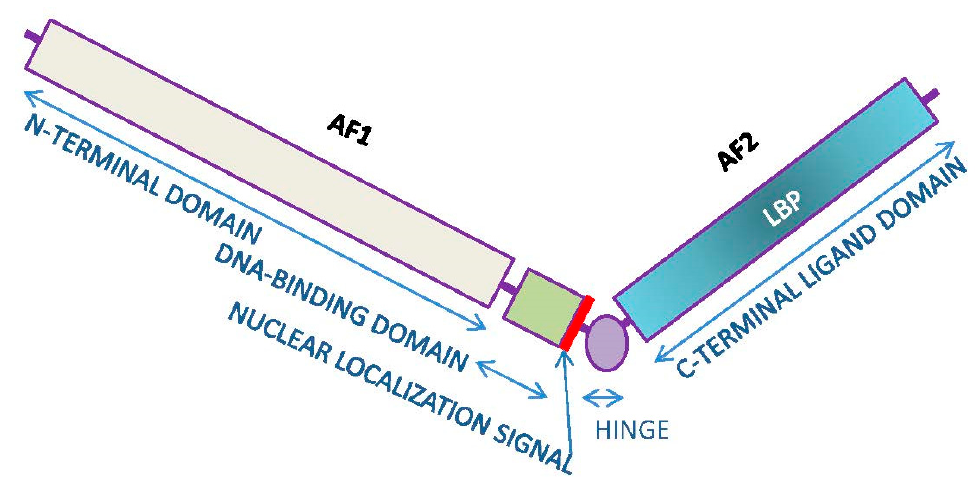
Figure 3. Functional structure of the androgen receptor (AR). The diagram shows the two distinct parts of the protein chain, joined at a flexible joint (hinge). The longest arm contains the N-terminal domain, incorporating the AF1 (activation function 1) binding sites, as well as the DNA-binding domain and a short sequence (nuclear localization signal) needed for the nuclear transport of the AR. The shorter arm (C-terminal domain) contains the AF2 (activation function 2) binding site. This domain contains a key binding niche, the LBP (ligand-binding pocket), in the core of